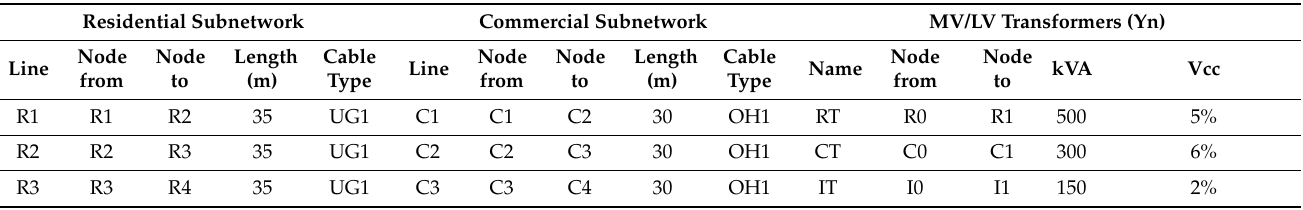
Table A2. Details about the connections among grid nodes, the characteristics of the loads tied to the grid, and the parameters of MV/LV transformers feeding the three subnetworks considered in the application example in Figure